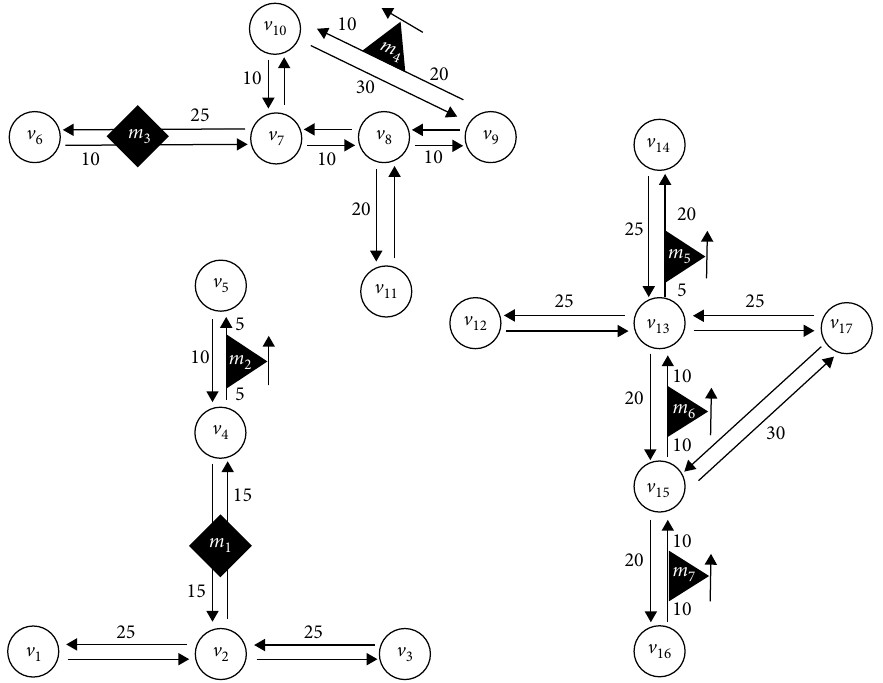
Figure 2: Three detour examples of a directed transportation